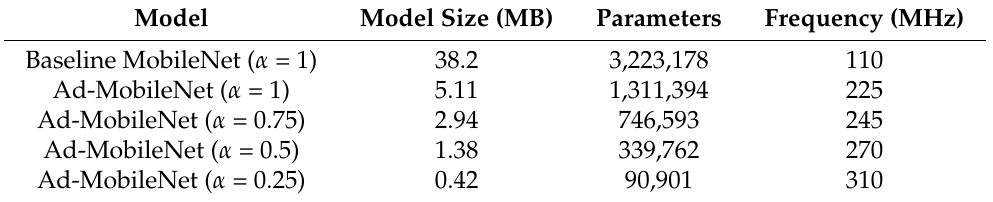
Table 4. Performance of Ad-MobileNet model using ReLU activation function on varying alpha.